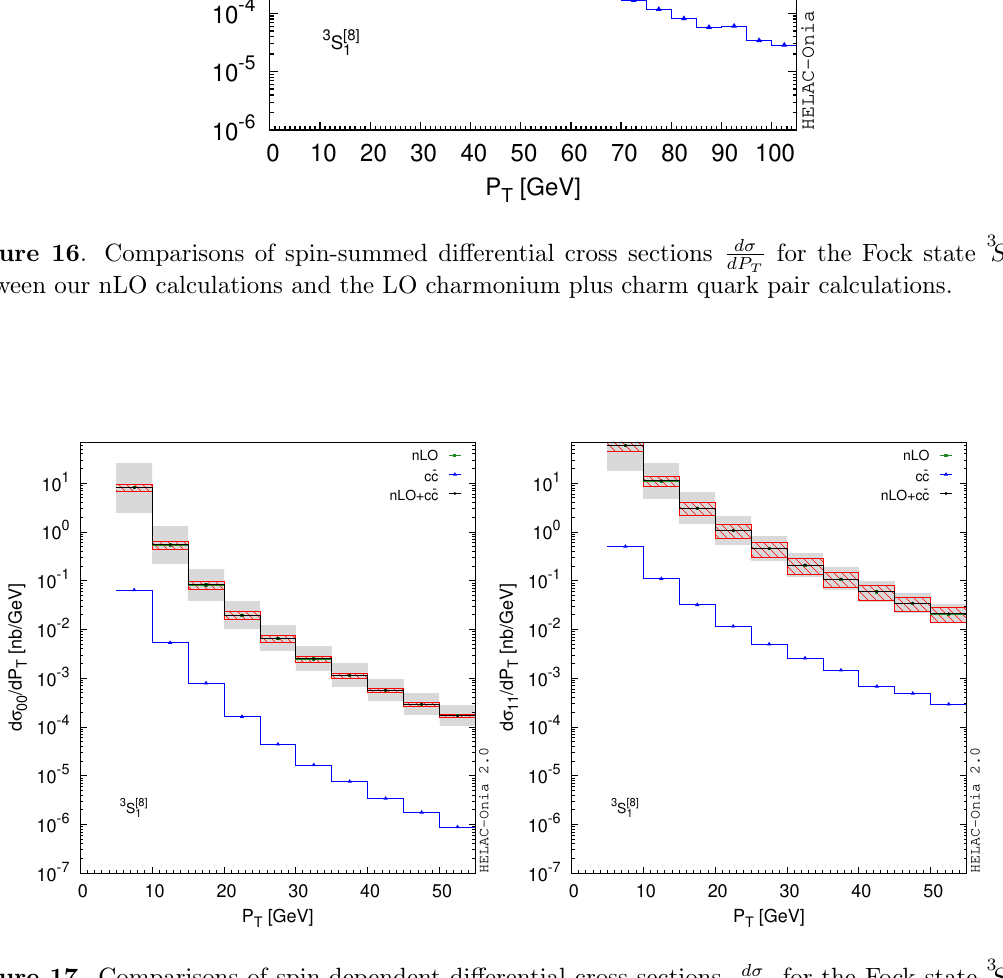
for the Fock state 3 S [8] 1 dP T